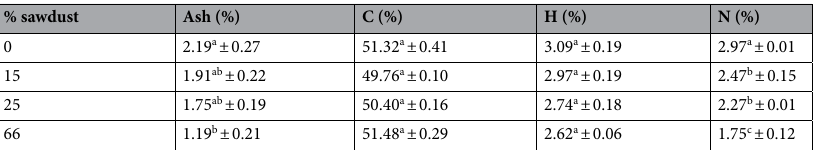
Table 6. Elemental analysis and ashes of the 4 tests carried out. Data are presented as mean ± standard error. The letter in each row indicates a significant difference between the sawdust content at P ≤